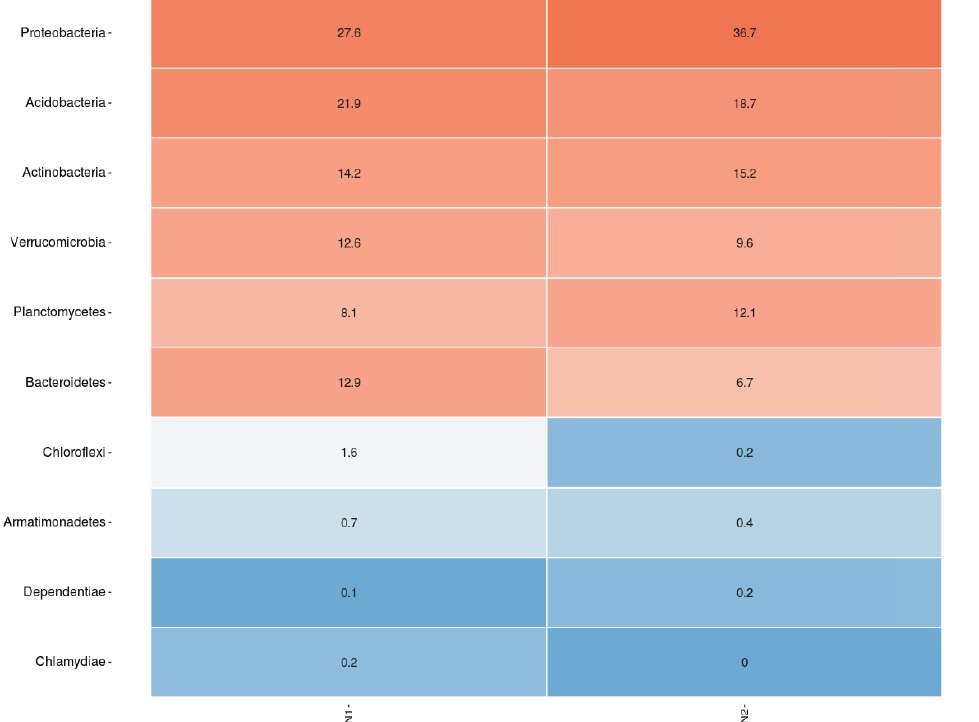
Figure 5: Top 10 phyla in N1_R1 and N2_O samples. Numbers show percentage content of each phylum in a